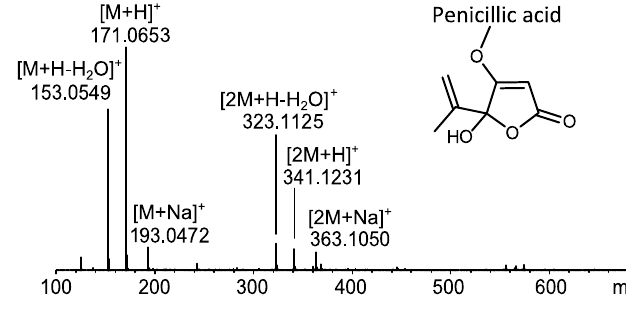
O] + and the sodiated 2 O] + , 2